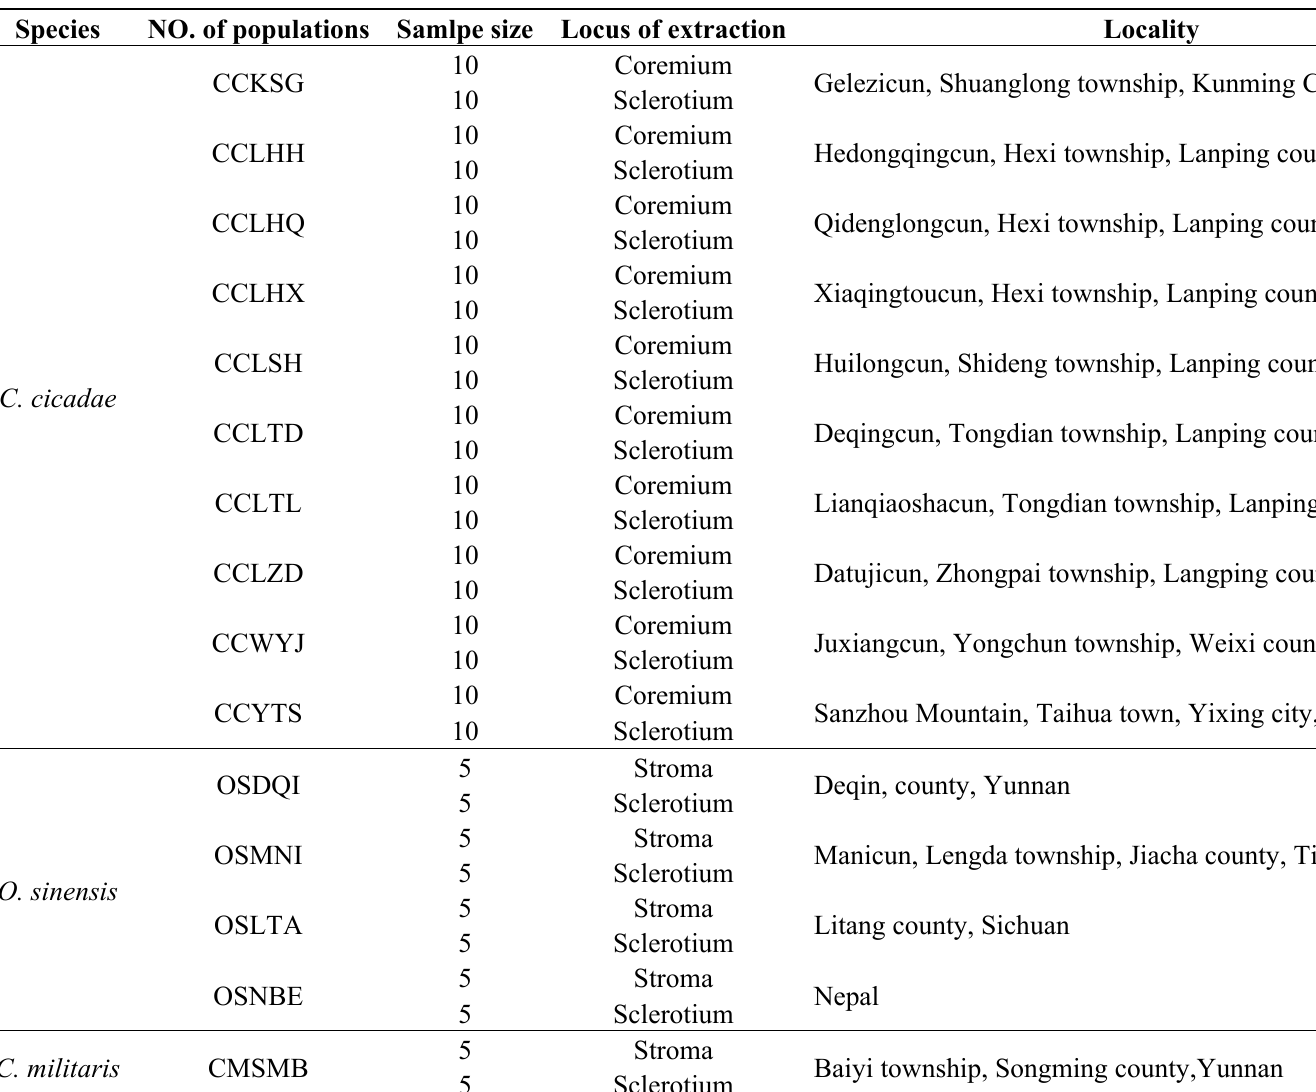
Table 5. Localities of the 10 populations of C. cicadae , four populations of O. sinensis and one population of C. militaris